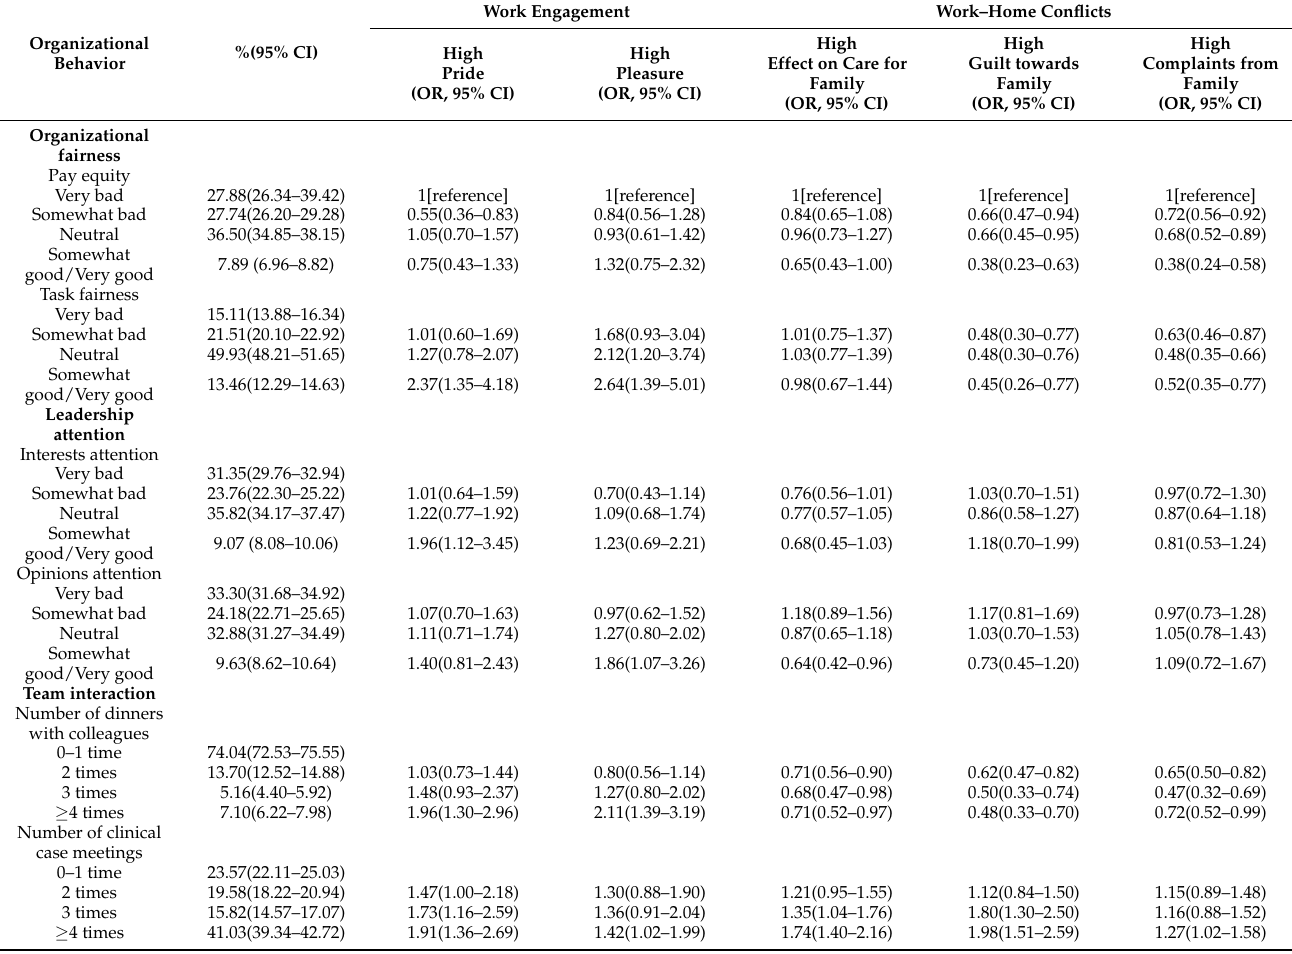
Table 3. Multivariable logistic regression results for correlates of organizational behavior-related